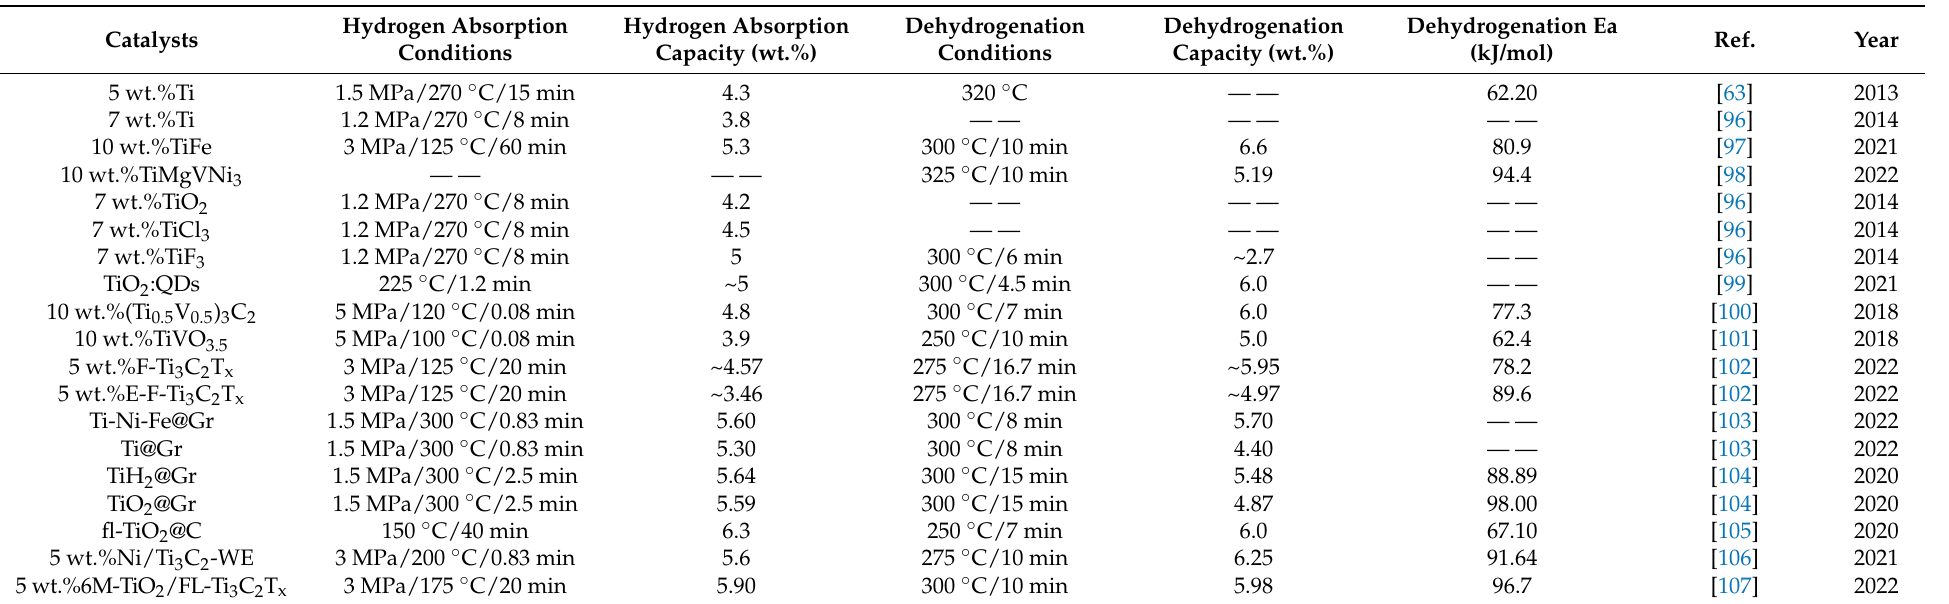
Table 5. Hydrogen storage performance of Mg/MgH 2 system doped with titanium-based